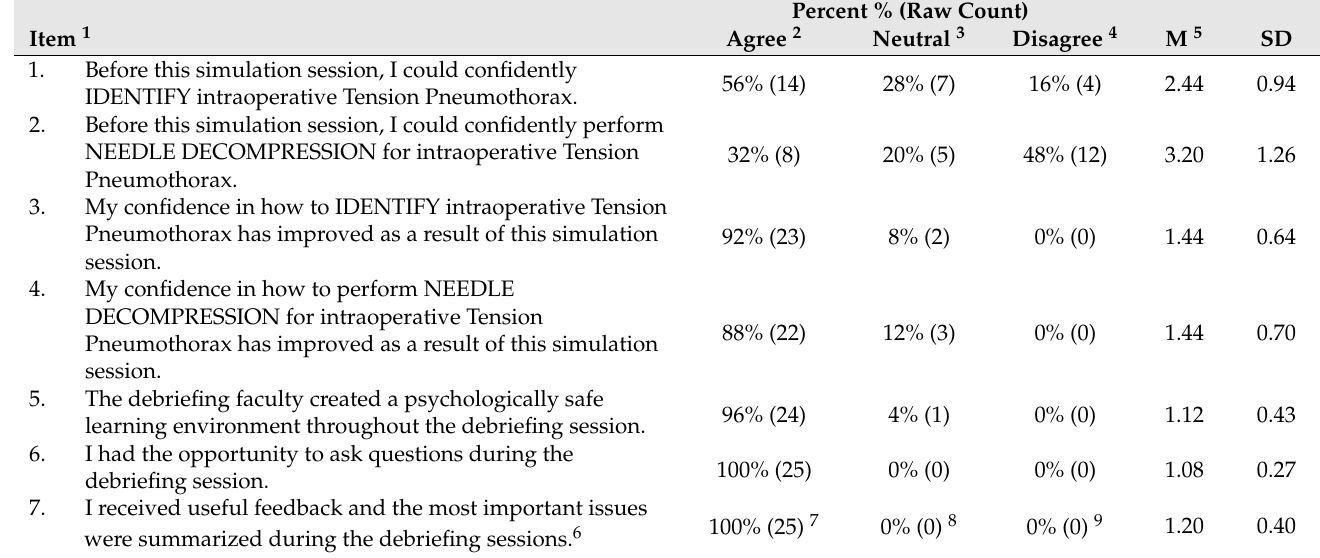
Table 1. Distribution of Survey Responses, Item Mean Scores, and Standard Deviations (N =